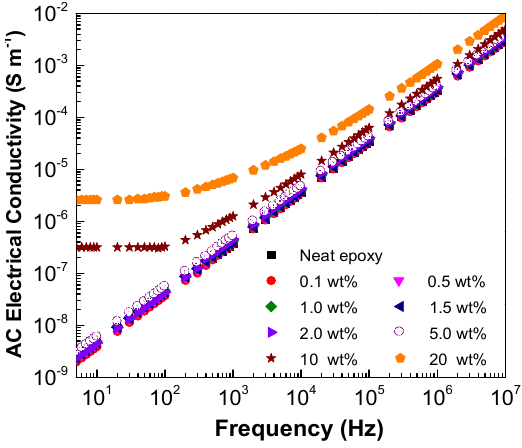
Figure 2. AC electrical conductivity of GNP/epoxy nanocomposites with varying content of GNP with a surface area of 300 m 2 g −1 .